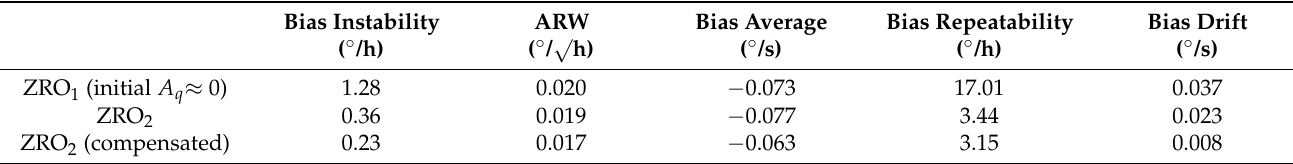
Figure 13. Allan variance curve of ZRO at room temperature. Table 4. Comparison of bias performance at room temperature.